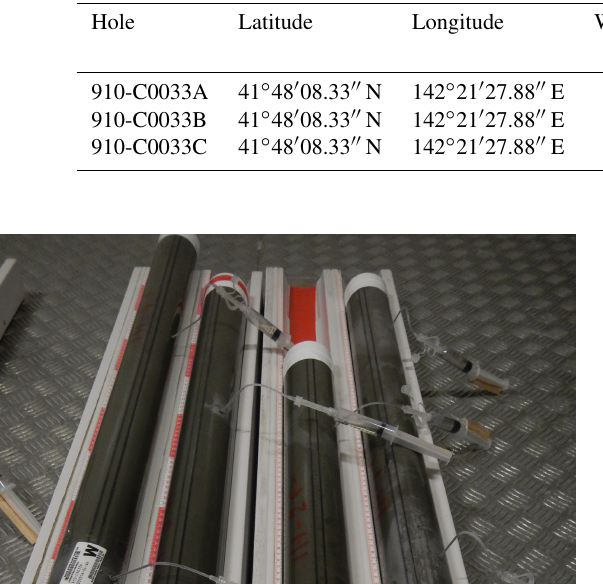
Table 1. Hole and coring summary.